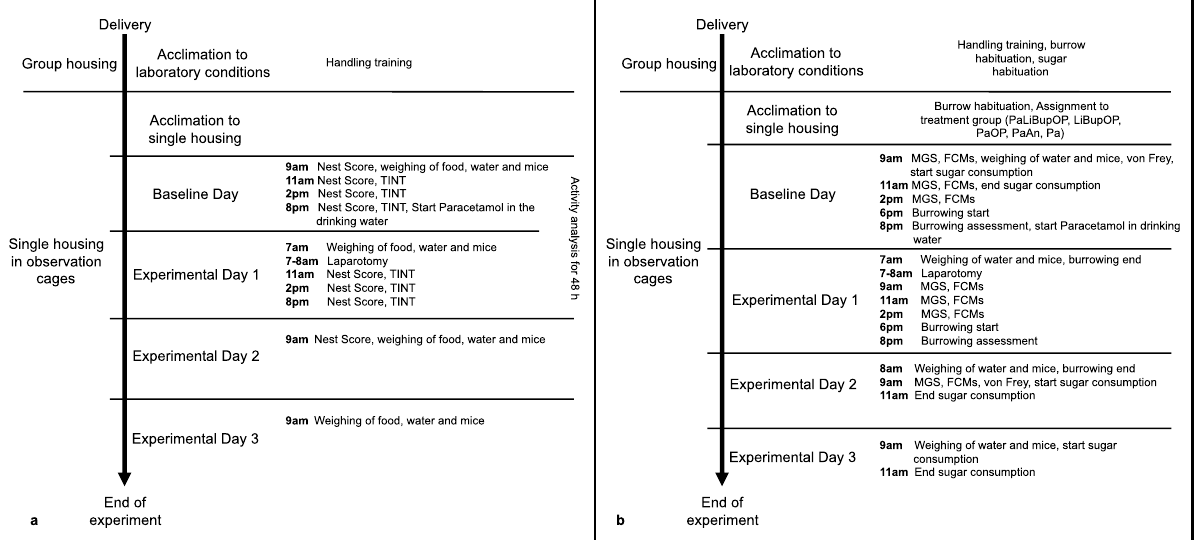
Figure 1. Experimental schedule displaying the procedures in both setups, such as the acclimation to laboratory conditions and single housing or handling training, as well as procedures uniquely performed in setup 1 ( a ) or setup 2 ( b ). TINT time to integrate nest material into the nest test, MGS Mouse Grimace Scale, FCMs fecal corticosterone metabolites. In both setups, n = 10 mice were assigned to PaLiBupOP, LiBupOP, PaOP, and PaAn groups. In setup 2, Pa was augmented with n = 8 female mice and n = 10